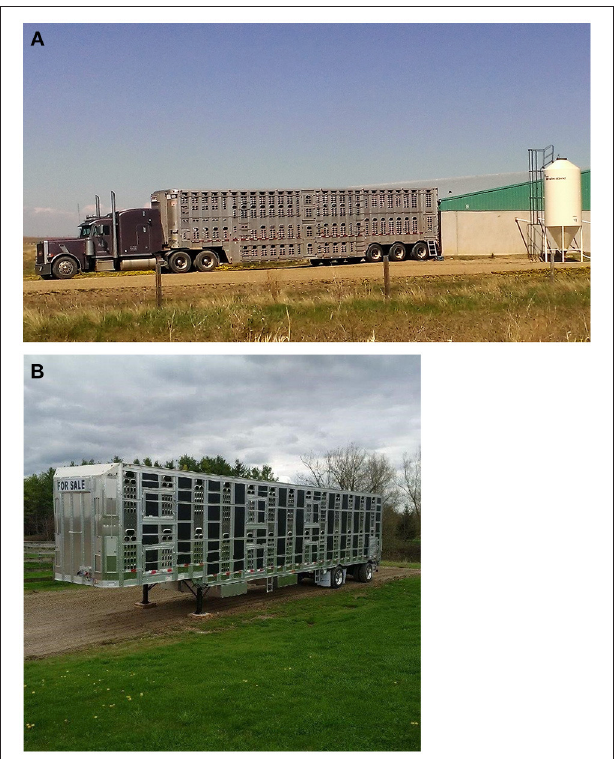
FIGURE 1 | Types of vehicles used in Canada: (A) “pot belly”; and (B) flat deck trailers (courtesy of E. Brockhoff, Prairie Swine Health Services, Canada, and A. Hurst, Luckhart Transport Ltd., Canada).